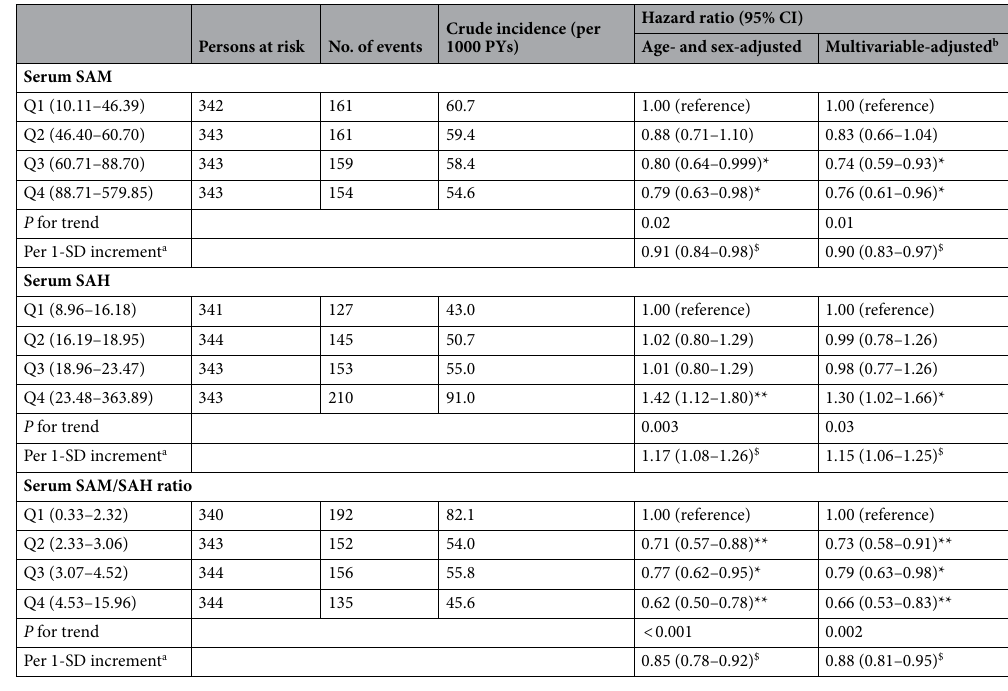
Table 2. The risk of all-cause dementia or death according to serum SAM, SAH and SAM/SAH ratio levels (2007–2017). CI confidence interval, PYs person-years, SAH s-adenosylhomocysteine, SAM s-adenosylmethionine, SD standard deviation. a 1-SDs of natural log-transformed values of serum SAM, serum SAH, and the serum SAM/SAH ratio were 0.46, 0.32, and 0.54. b Adjusted for age, sex, education, hypertension, diabetes mellitus, serum total cholesterol, body mass index, history of stroke, current smoking, current drinking, regular exercise and use of vitamin B supplements. * P < 0.05, ** P < 0.01 versus Q1. $ P < 0.05 per 1-SD